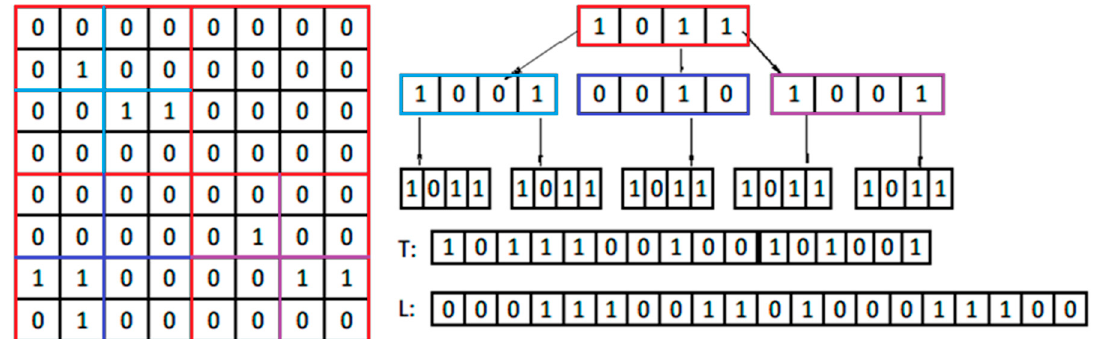
2 -tree example where K =